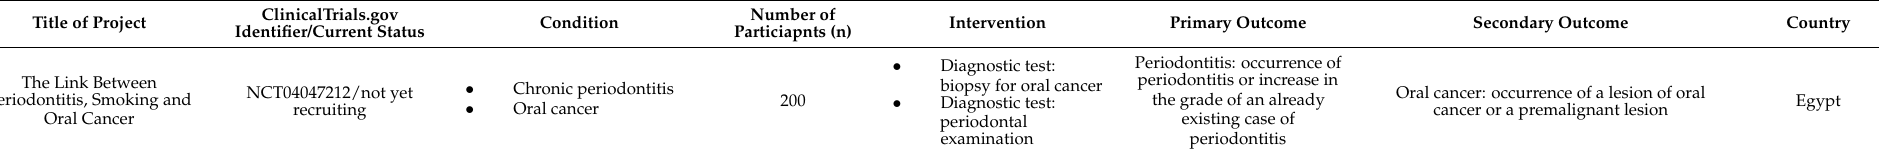
Table 2. Studies which are registered in ClinicalTrials.gov system regarding periodontal diseases and cancer aspects. ND—no data; NA—not